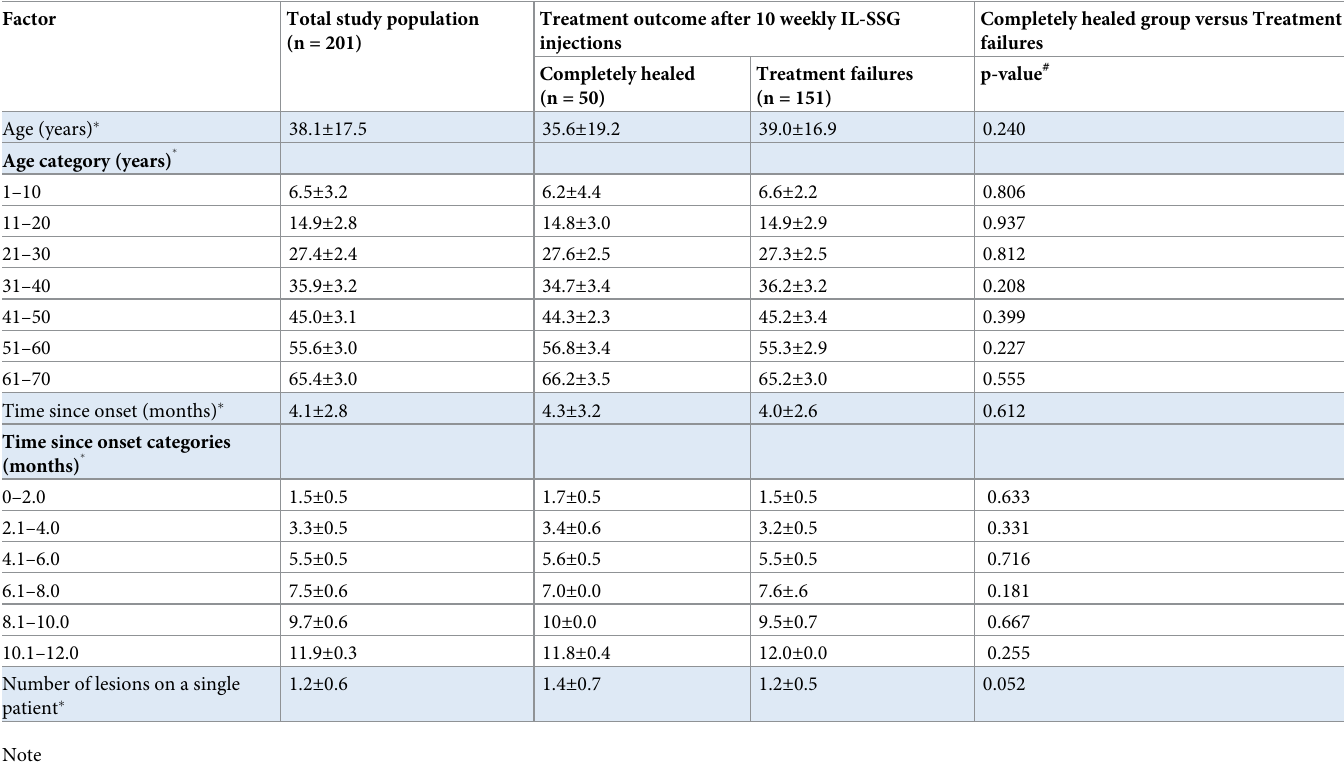
Table 1. Characteristics of cutaneous leishmaniasis patients recruited for the study and comparison between the ‘completely healed’ and ‘treatment failure’ groups.